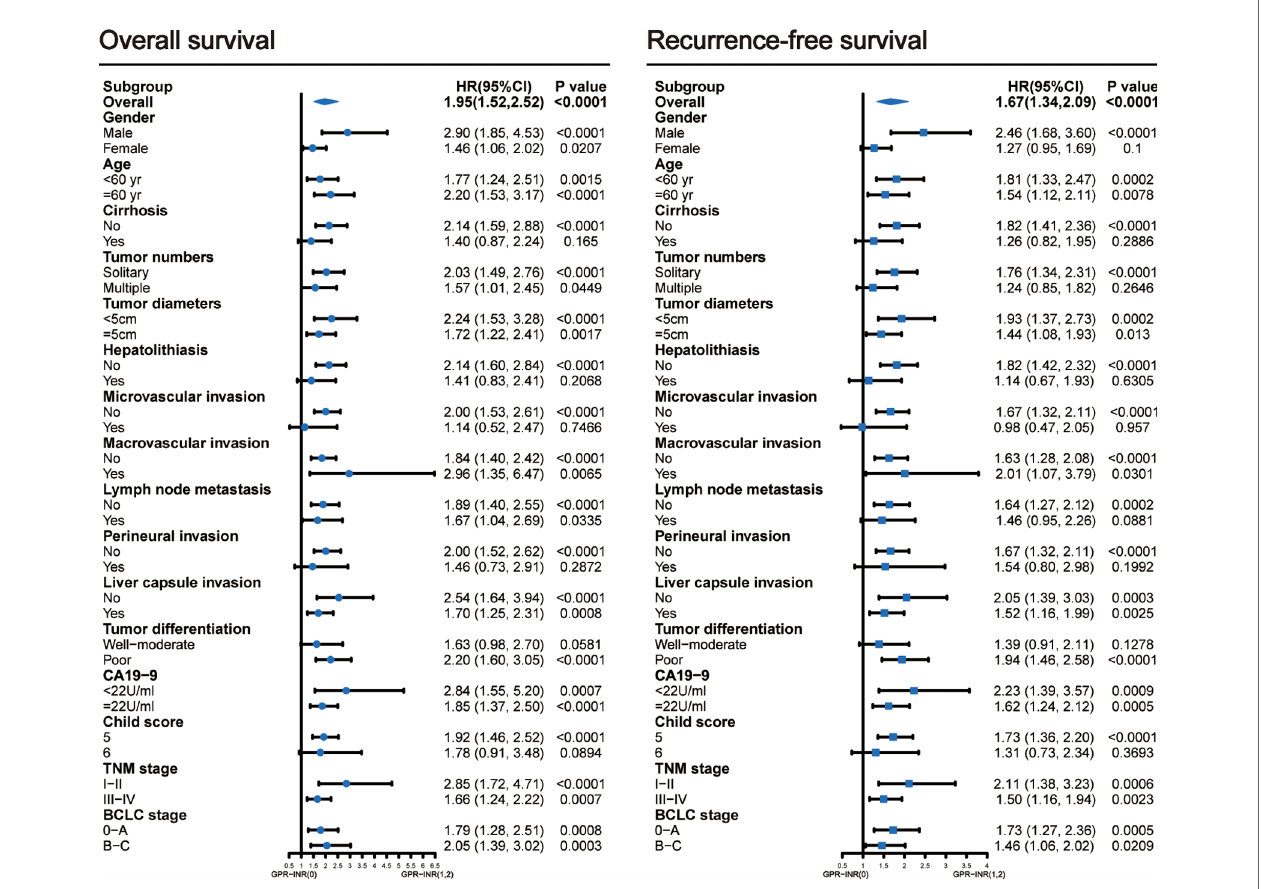
FIGURE 2 | Subgroup analyses using univariable Cox regression to assess the discrimination ability of the GPR-INR score for overall survival and recurrence-free survival in patients with different clinical characteristics. CI, con fi dence